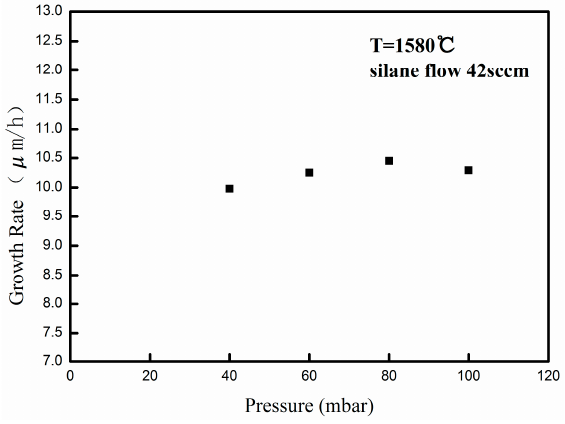
Figure 1. Dependence of 4H-SiC epitaxial growth rate on process pressure.